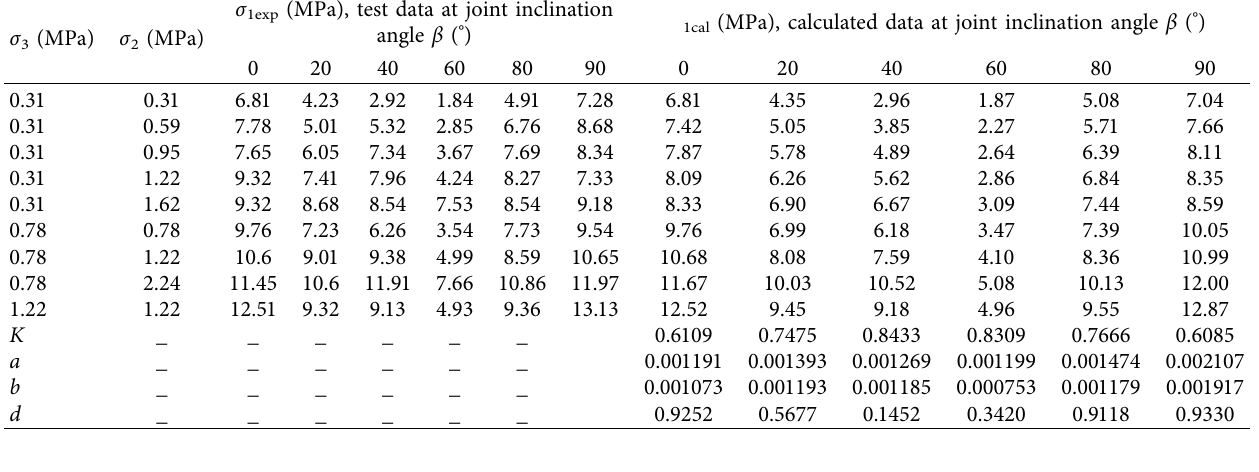
Table 3: True triaxial compression strength of experimental and predicted results of rock mass models (data from [14]; here, compressive stress is considered